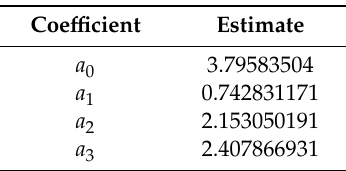
Table 3. Estimated result of the constants using excel